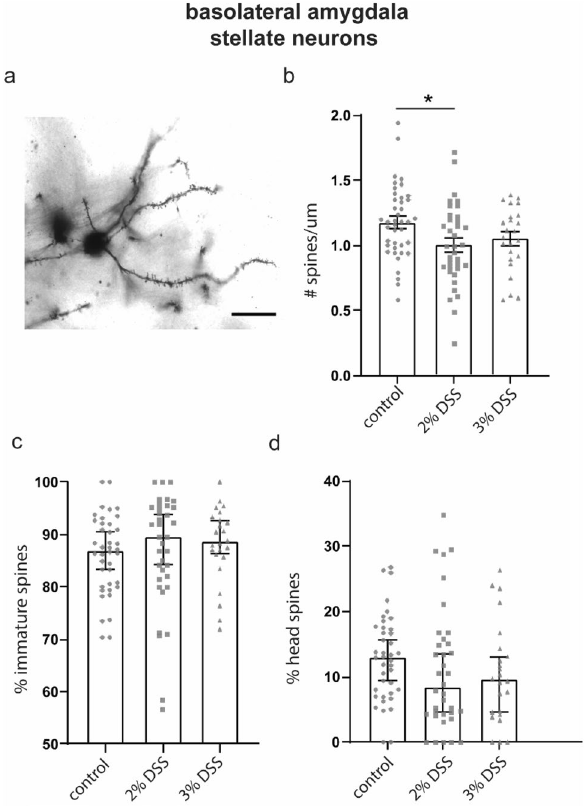
Figure 4. Spine density and composition of stellate neurons in the basolateral amygdala. ( a ) Representative image of a stellate neuron; scale bar 25um. ( b ) Density of spines on dendrites in BLA; data shown are mean ± SEM. Proportion of immature spines ( c ) and head spines ( d ) on dendrites in the BLA; data shown are median ± 95% CI. Density data analyzed by One-way ANOVA with Dunnett’s post-test to negative control, data shown as mean ± SEM, *p < 0.05. Composition data analyzed by Kruskal–Wallis. n = 24–40 dendrites, from 12 to 19 neurons, from 6 animals per